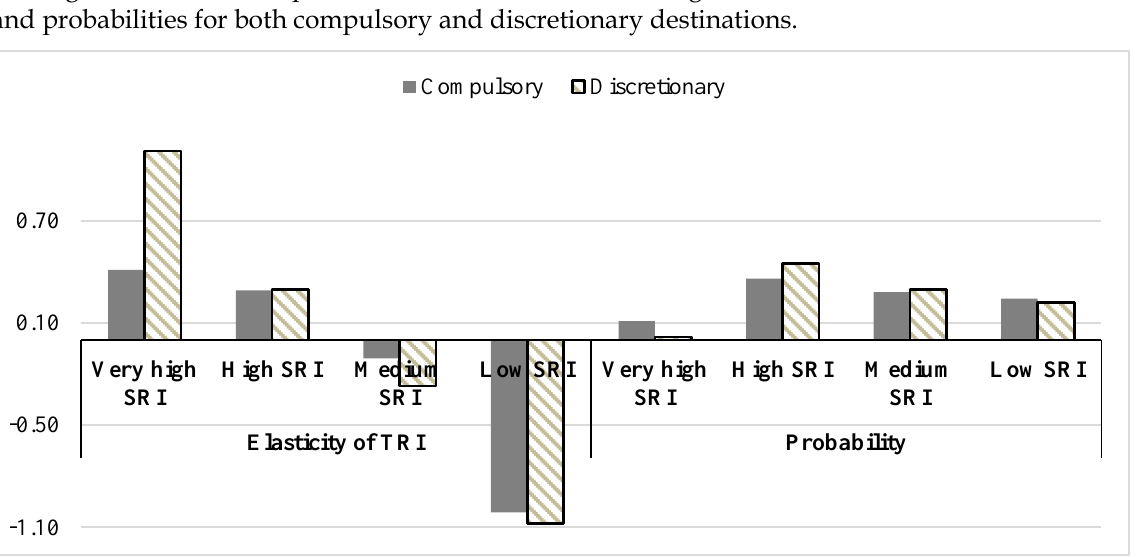
Figure 4. Elasticity of TRI and probability: Low (0-25%), medium (26-50%), high (51-75%) and very high (75-100%)